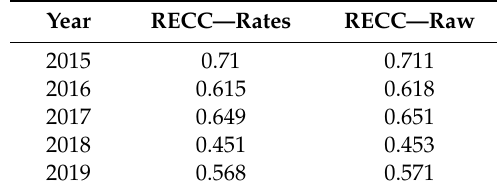
Table4. RareEventConcentrationCoe ffi cient(RECC)forOverdoseDeathsintheTargetArea,2015–2019. Year